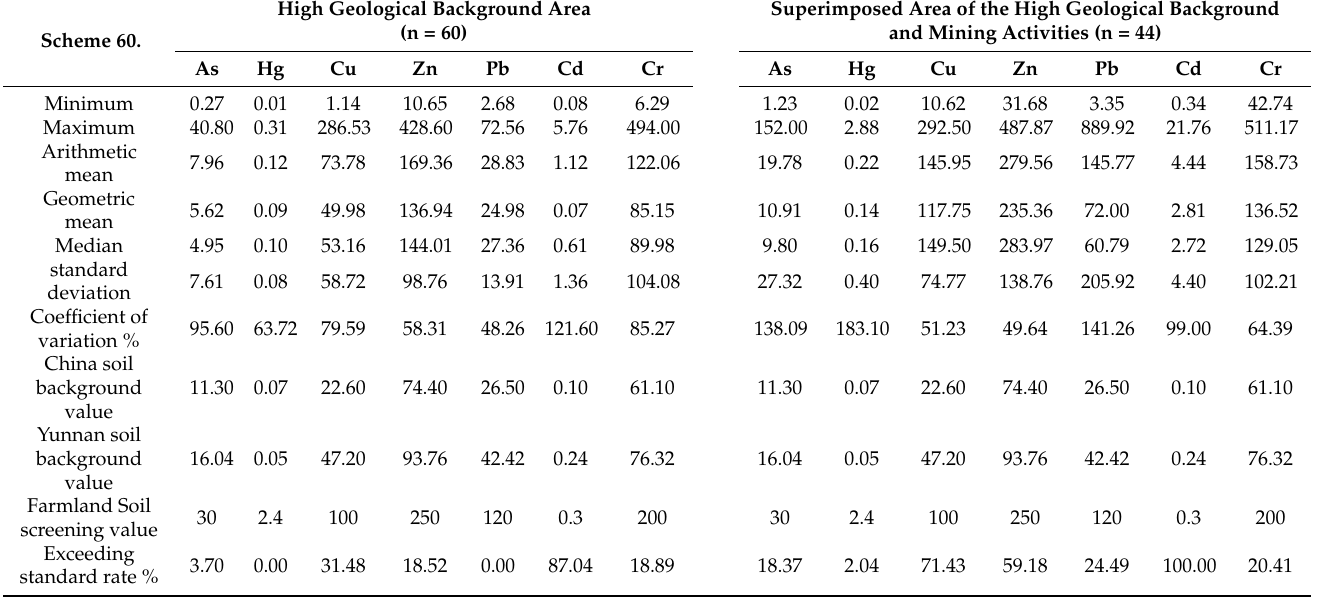
Table 2. Statistical values, background values, and standard limits of PTEs in soil (mg · kg − 1